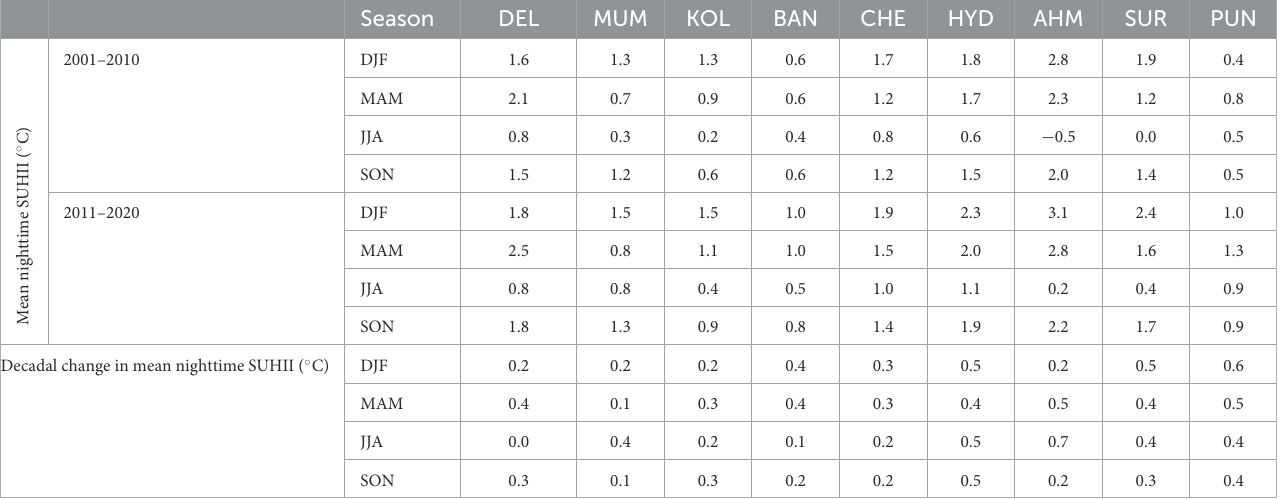
TABLE 2 Mean nighttime SUHII ( ◦ C) for seasons DJF, MAM, JJA, and SON during the decades 2001–2010, and 2011–2020 along with its decadal change for the nine major populated cities of India. In the Table these cities are represented as- Delhi (DEL), Mumbai (MUM), Kolkata (KOL), Bangalore (BAN), Chennai (CHE), Hyderabad (HYD), Ahmedabad (AHM), Surat (SUR), and Pune